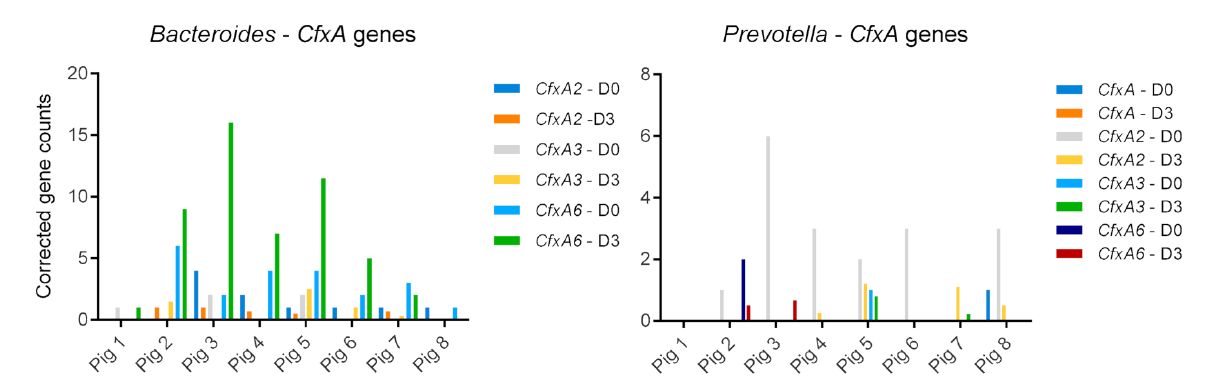
Figure 8. Bar plots showing the CfxA resistance gene counts on Bacteroides and Prevotella per pig, before and after treatment, corrected to the relative (pre-treatment to post-treatment) base counts of Bacteroides and Prevotella. D0 = day 0, D3 = day 3, i.e., 9 h after the last dose of the